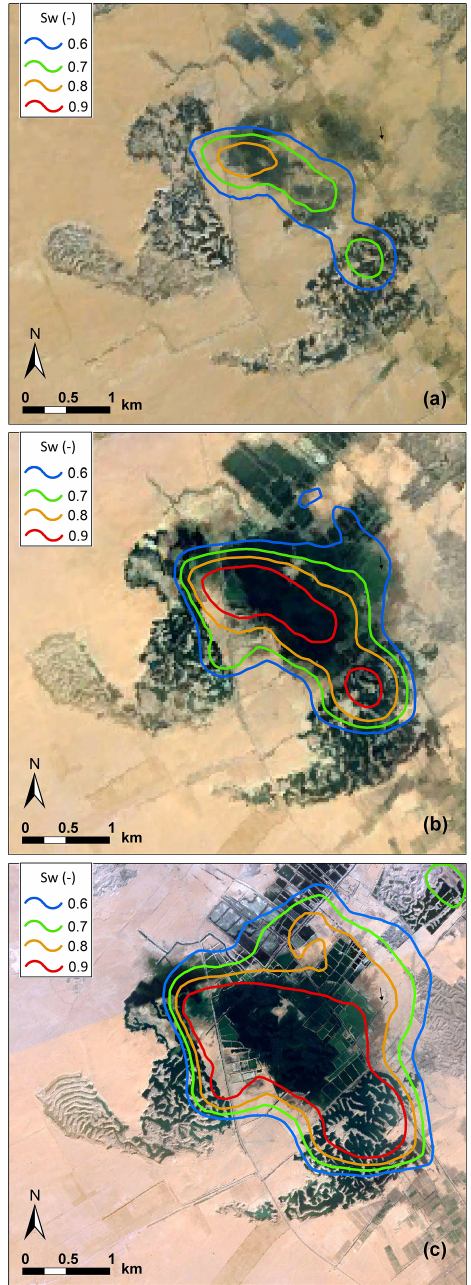
Figure 10. The contour lines of the saturation degree at the land surface around the depression in (a) 2007, (b) 2010, and (c) 2014 as obtained by the 3-D pond-scale model. The backgrounds are Land- sat images acquired in 2007, 2010, and 2014, respectively, which are available from the US Geological